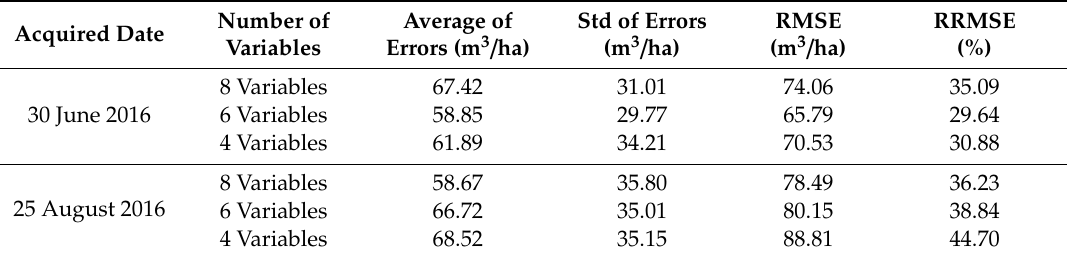
Table 6. The estimation accuracies of forest GSV using the saturation-based multivariate method. Acquired